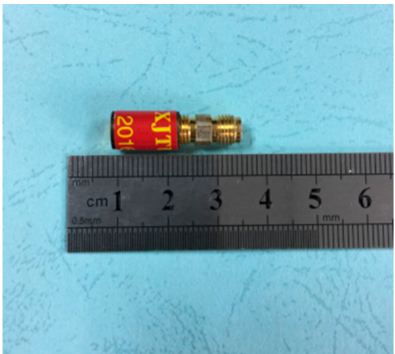
Figure 3. Photograph of the BNT-BT transducer.